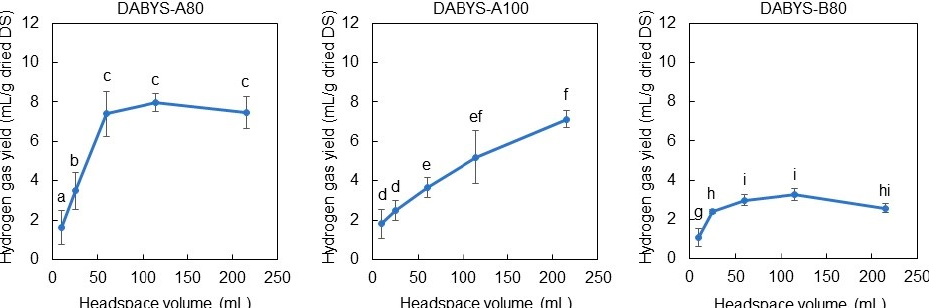
Figure 7. Influence of headspace volume on the hydrogen-producing activity of DABYS-A80, -A100, and -B80 in the 1-month dark fermentation. The data are presented as the mean ± standard deviation of independent triplicates. The letters indicate significant differences at p < 0.05 (Student’s t -test).